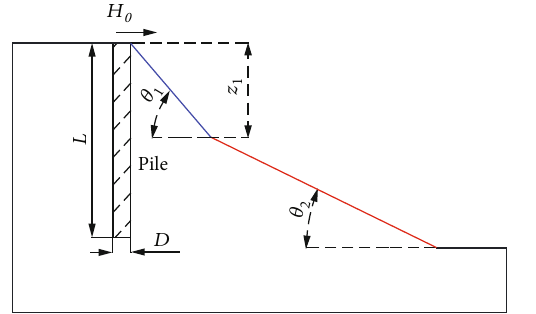
Figure 1: Analysis model of a laterally loaded pile on a concave slope. Here, L is the length of the pile embedded in the soil, D is the pile diameter, H is the lateral load on the pile head, θ 0 is the lower slope angle, and Z upper slope angle, θ 2 slope